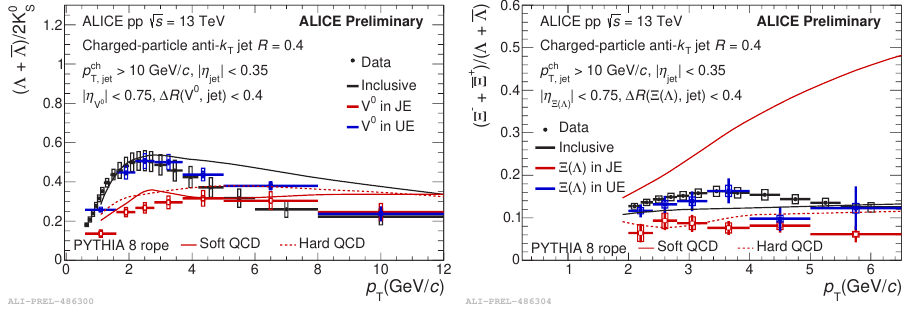
+ (left) and ( Ξ − + Ξ ) / ( Λ + Λ ) S > 10 GeV / c were reconstructed T , jet